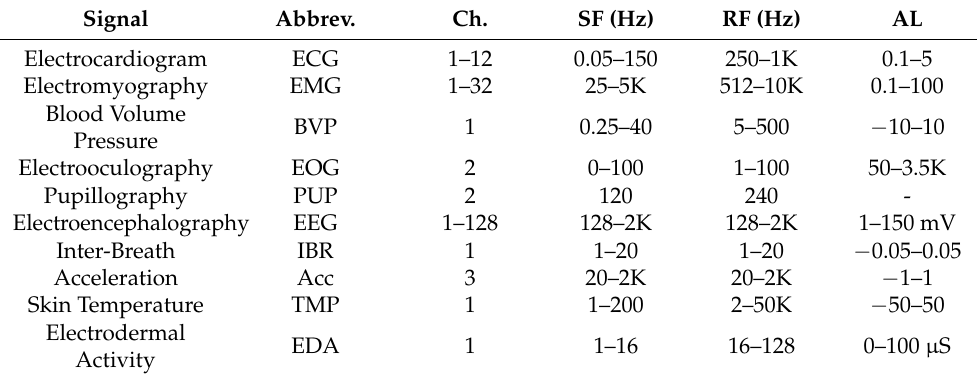
Table 2. Bio-signals and their properties.